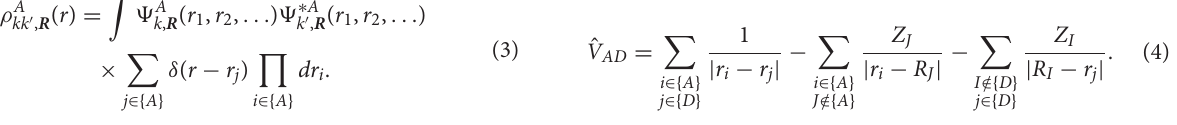
where r A = ( r 1 , r 2 , . . . ) is a collection of electronic